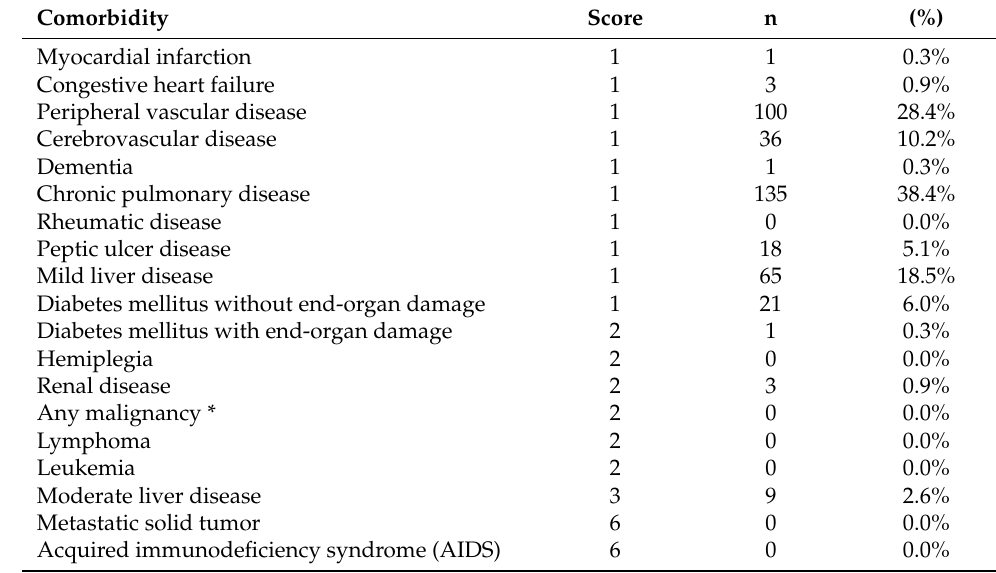
Table 1. Comorbidity distribution based on the Charlson comorbidity index (n = 352).